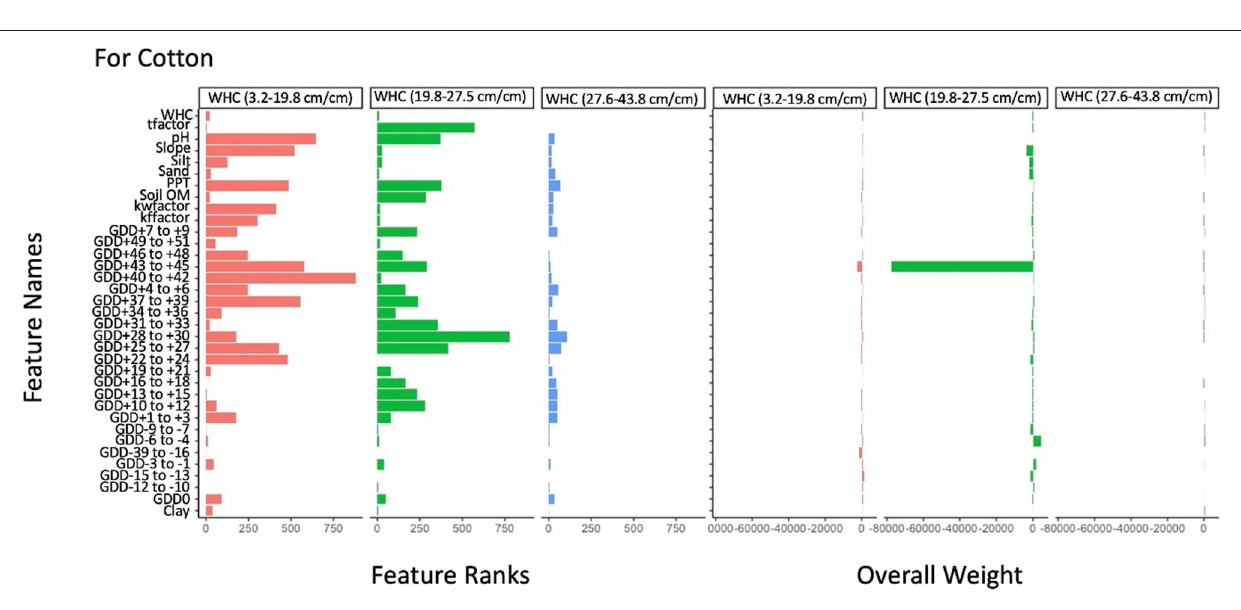
FIGURE 12 | Feature ranks and overall weight of features following explainable machine learning interpretations for cotton for low, medium, and high quartiles of water holding